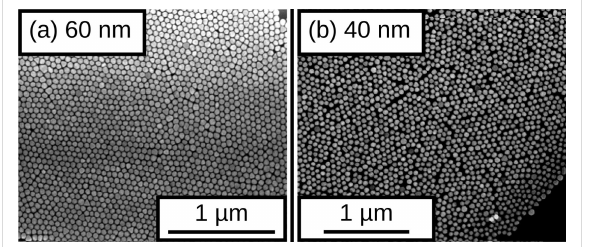
Figure 4: SEM images of monolayer assemblies of commercial Au nanoparticles with (a) 60 nm diameter and (b) 40 nm diameter on Si/ SiO 2